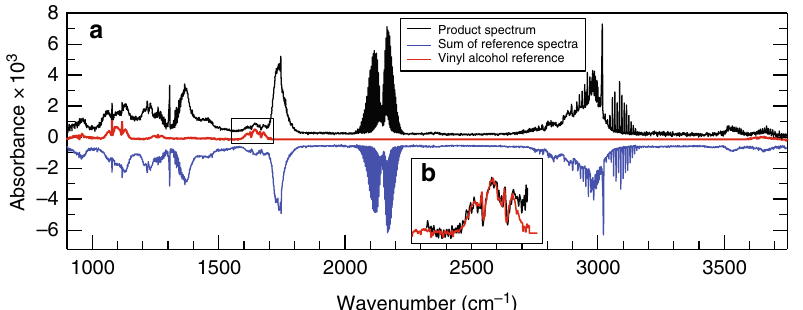
Fig. 1 Fourier transform infrared spectra of the photolysis products. a Infrared spectrum (black) following 7 min of 315 nm irradiation of a mixture of 10 Torr acetaldehyde in 750 Torr nitrogen. The remaining acetaldehyde has been subtracted from the spectrum. The inverted blue trace shows the sum of scaled reference spectra of photochemical products. The red trace is an infrared reference spectrum of vinyl alcohol, a portion of which, between 1550 and 1700 cm – 1 , is expanded in the inset